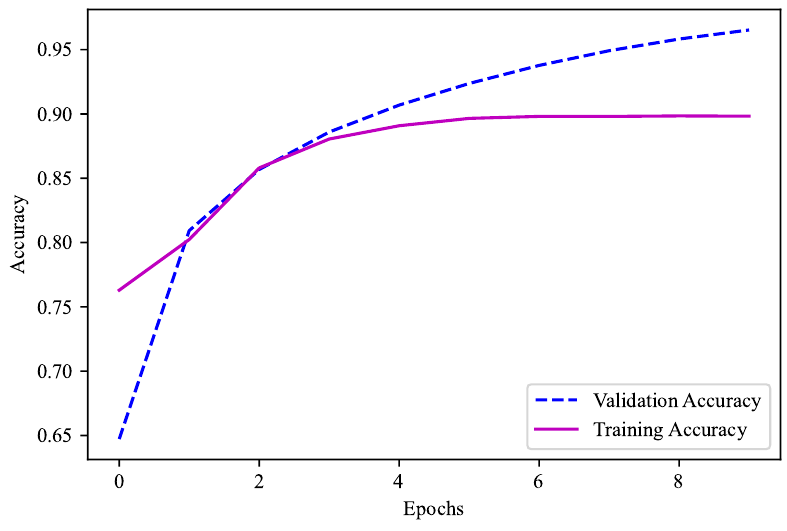
Figure 14. Validation accuracy for model 2 (Temperature 0.0–0.9).